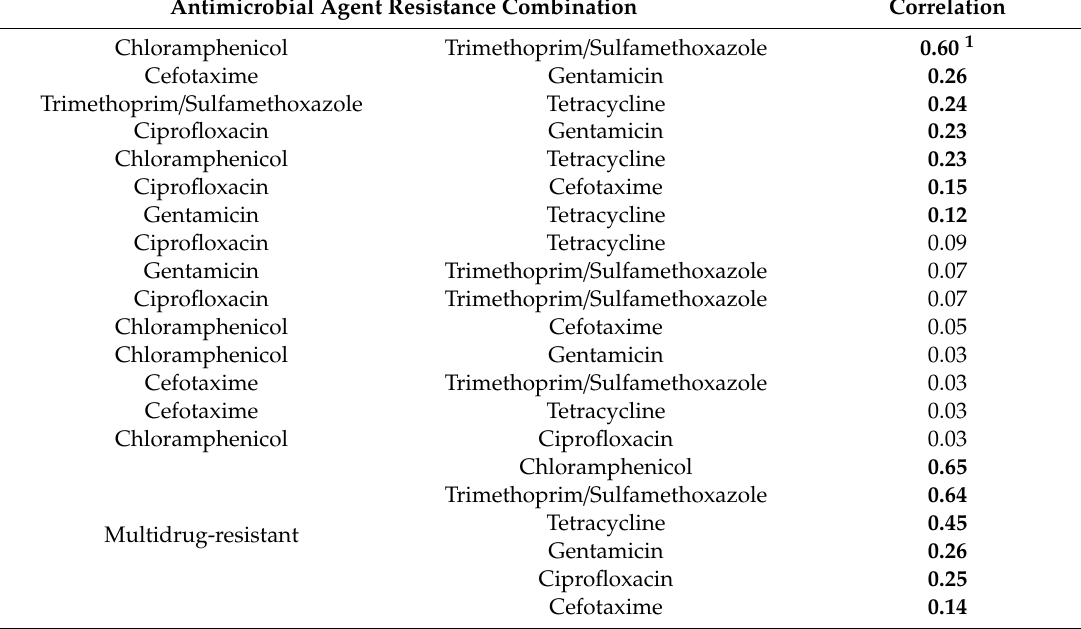
Table 4. Pairwise correlation between two antimicrobial resistance statuses in E. coli isolates collected at small- and medium-scale farms in North Eastern Thailand. Antimicrobial Agent Resistance Combination